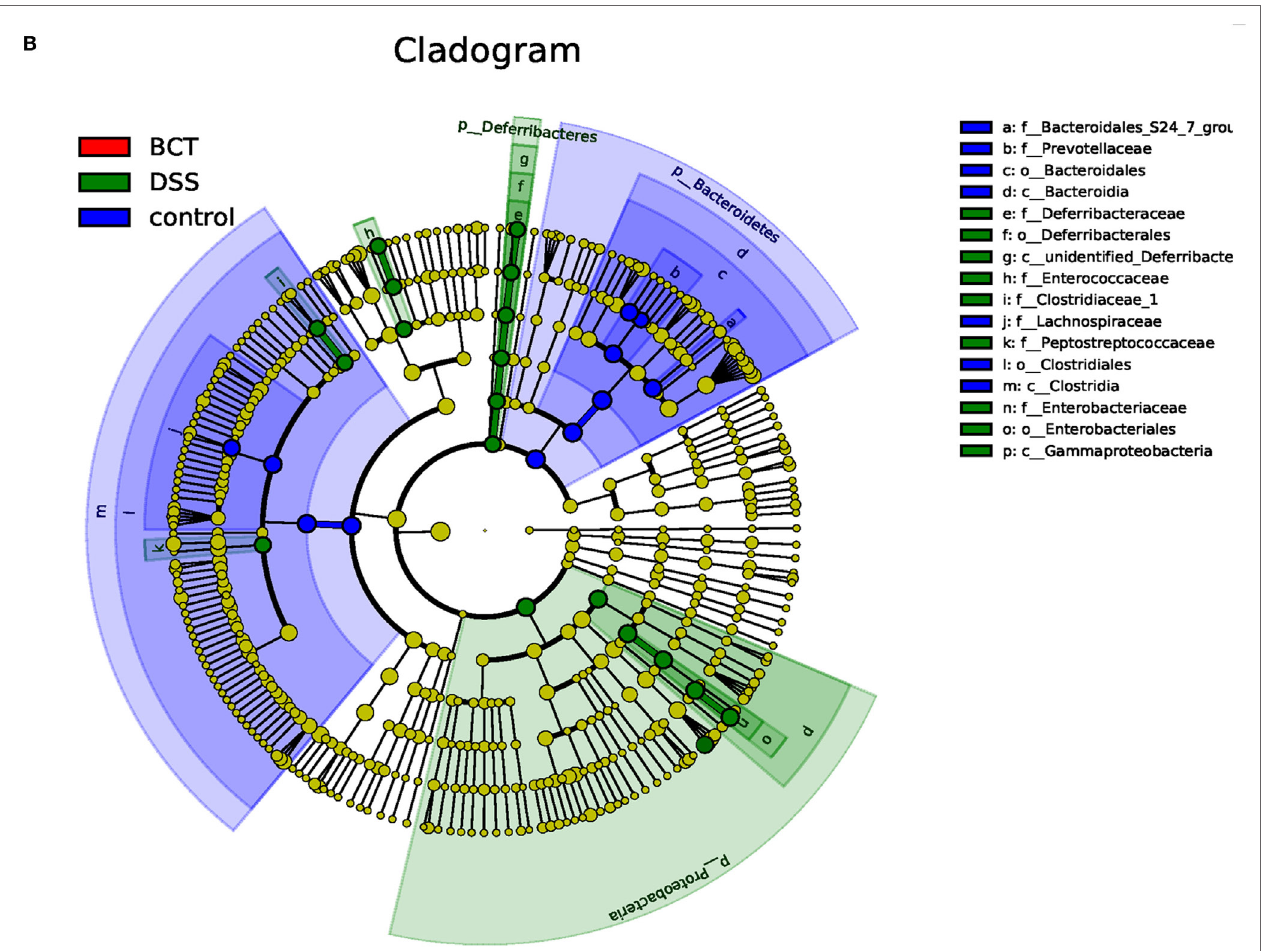
FigUre 6 | LEfSe analysis of intestinal microbiota among different mice groups. (a) LEfSe identified the most differentially abundant bacterial taxons among groups. Group-specific enriched taxa are indicated with a positive LDA score bar with different colors. Only taxa meeting an LDA significant threshold > 4 are shown. (B) Taxonomic cladogram obtained from LEfSe analysis of 16S rDNA sequences. The brightness of each dot is proportional to its effect